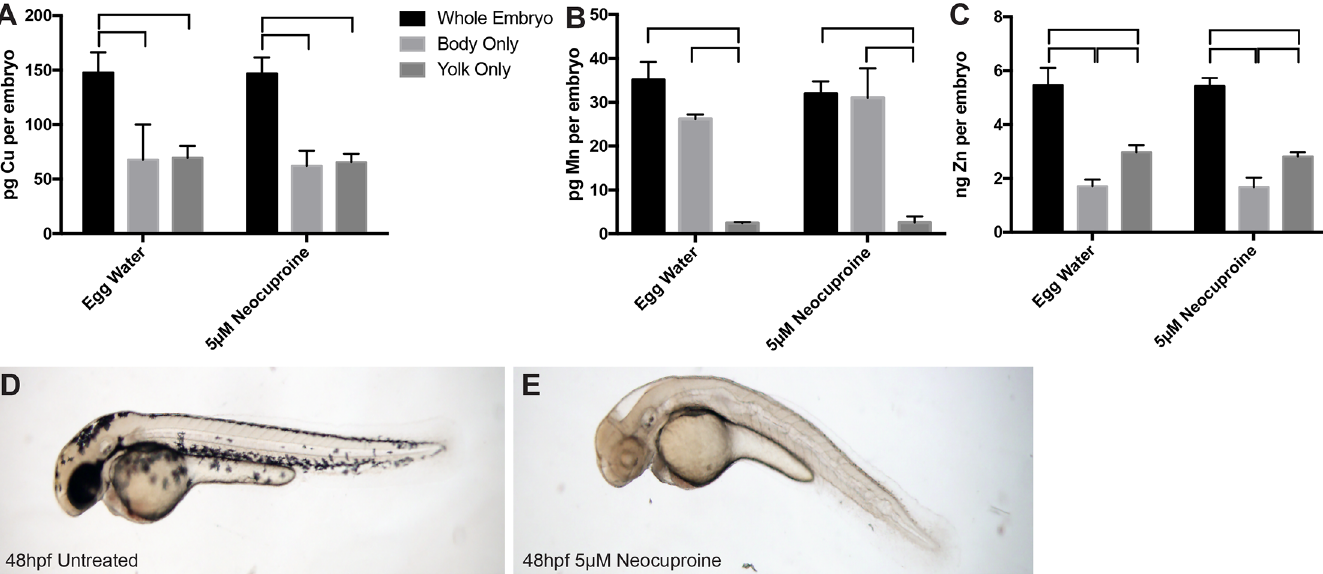
Fig 2. Distribution of metals in bodies and yolk sacs of embryos. (A-C) ICP-MS measurements were collectedfor copper (Cu) (A), manganese (Mn) (B), and zinc (Zn) (C) in wholeembryos, bodies only, and yolk sacs only of embryos at 48 hpf, reared in presence or absenceof 5 μ M neocuproine,a Cu chelator. Each bar represents the averageand standard deviationof three independently collectedreplicates, with each replicateconsistingof a pooled group of 47–50 embryos. Horizontalbrackets abovebars indicate statistically significantdifference betweenbracketedvalues. (Data in all panels passed Shapiro-Wilk normalityand equal variance tests. One-way ANOVA indicatedsignificantdifference betweengroups, with the Holm-Sidak method used for multiplecomparisons and P < 0.05 as cut-off for significance.) There was no significantdifference in metal levels betweenneocuproine-treated and–untreated samplesof the same sample type. (D, E) Images were taken of zebrafishembryos at 48 hpf, reared in presenceor absenceof 5 μ M neocuproine.